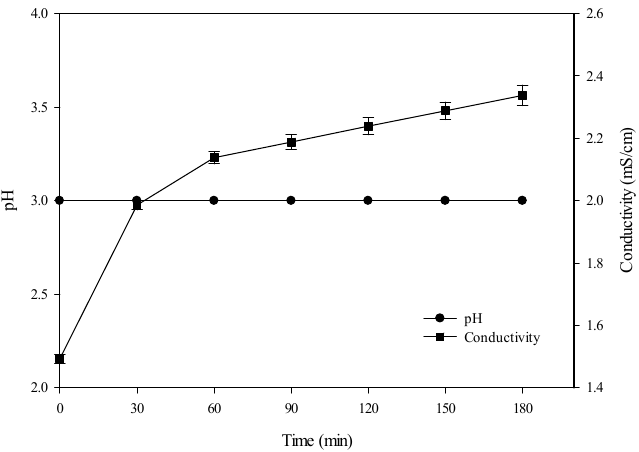
Figure 2. Evolution of pH and conductivity during conventional hydrolysis (control).